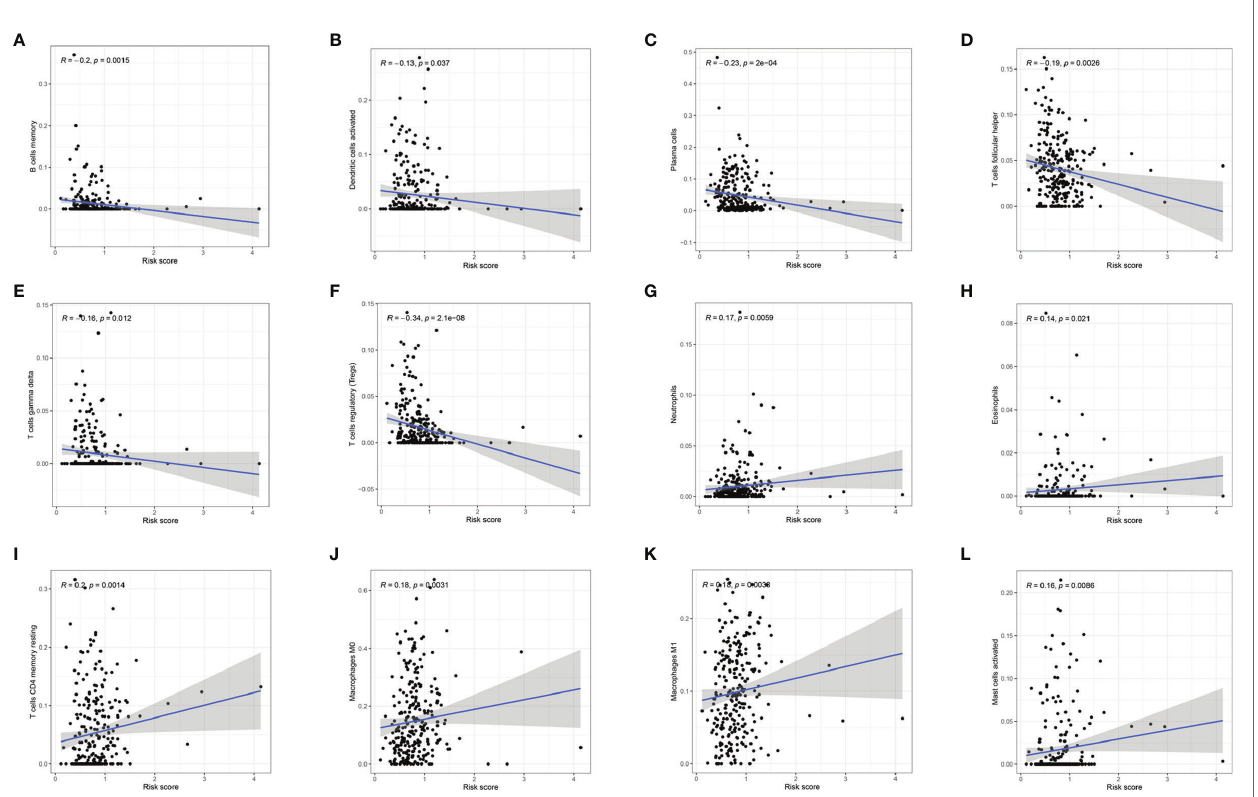
FIGURE 9 | Relationships between the risk score and the in fi ltration levels of 12 immune cell types. (A – F) The in fi ltration levels of memory B cells (A) , aDCs (B) , plasma cells (C) , Tfh cells (D) , gamma delta T cells (E) , and Tregs (F) were negatively correlated with risk score. (G – L) The in fi ltration levels of neutrophils (G) , eosinophils (H) , resting memory CD4 T cells (I) , M0 macrophages (J) , M1 macrophages (K) , and activated mast cells (L) were positively correlated with the risk